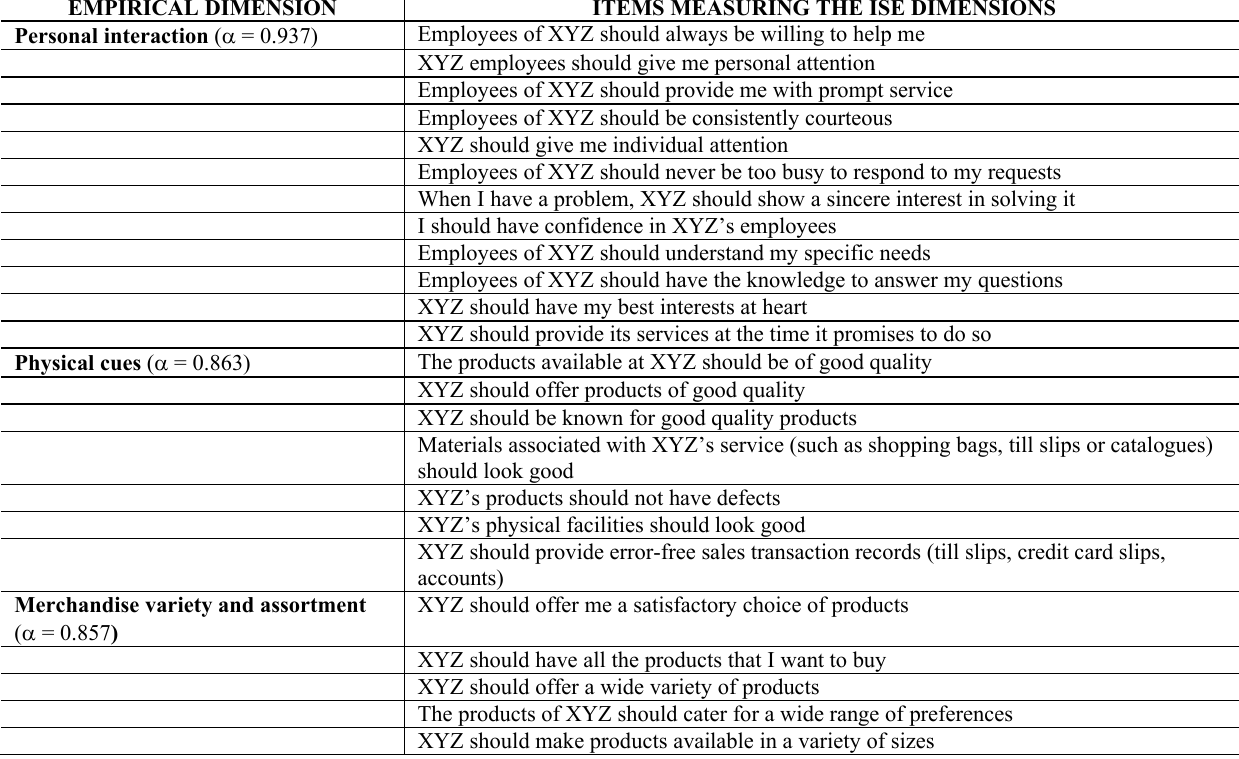
Table 1: Empirical factor structure: Survey 1 EMPIRICAL DIMENSION ITEMS MEASURING THE ISE DIMENSIONS Personal interaction ( α =